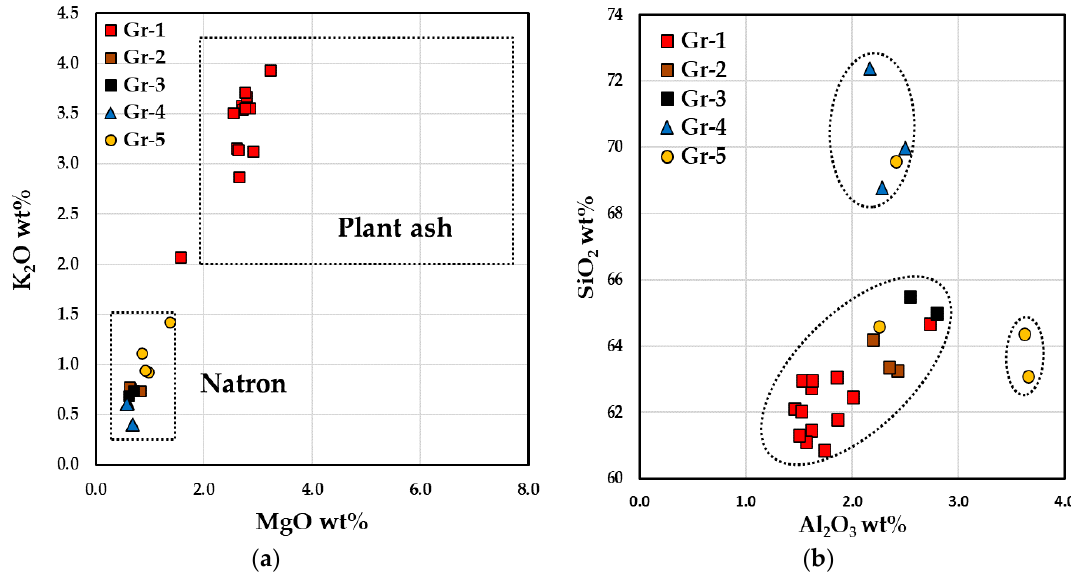
Figure 11. Bi-plot graph, reporting the concentrations from the reduced composition, of MgO vs. K 2 O ( a ), ( b ) Al 2 O 3 vs. SiO 2 of the base glass of the samples. Samples of the Gr-2, Gr-3, Gr-4 and Gr-5 groups exhibit low concentrations of MgO and K 2 O (both lower than 1 wt.%), as well as of P 2 O 5 ( < 0.3 wt.%) and CaO (from 6 to 8.1 wt.%), while a